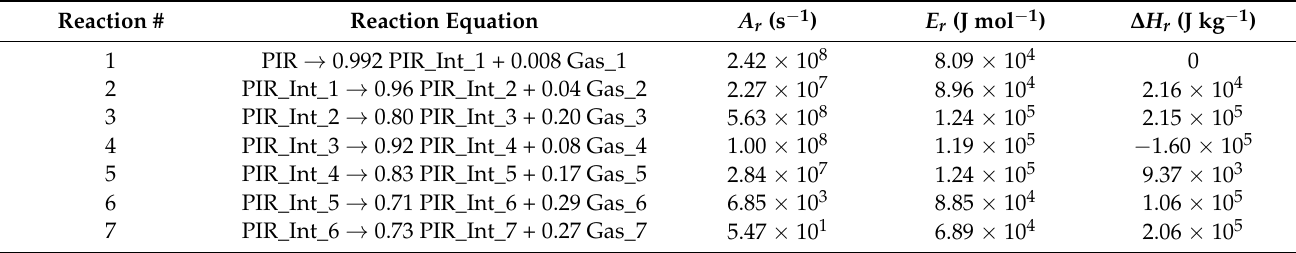
Table 1. The thermal decomposition reaction mechanism and parameters for the polyisocyanurate (PIR) foam. Positive ∆ H r corresponds to an endothermic reaction.